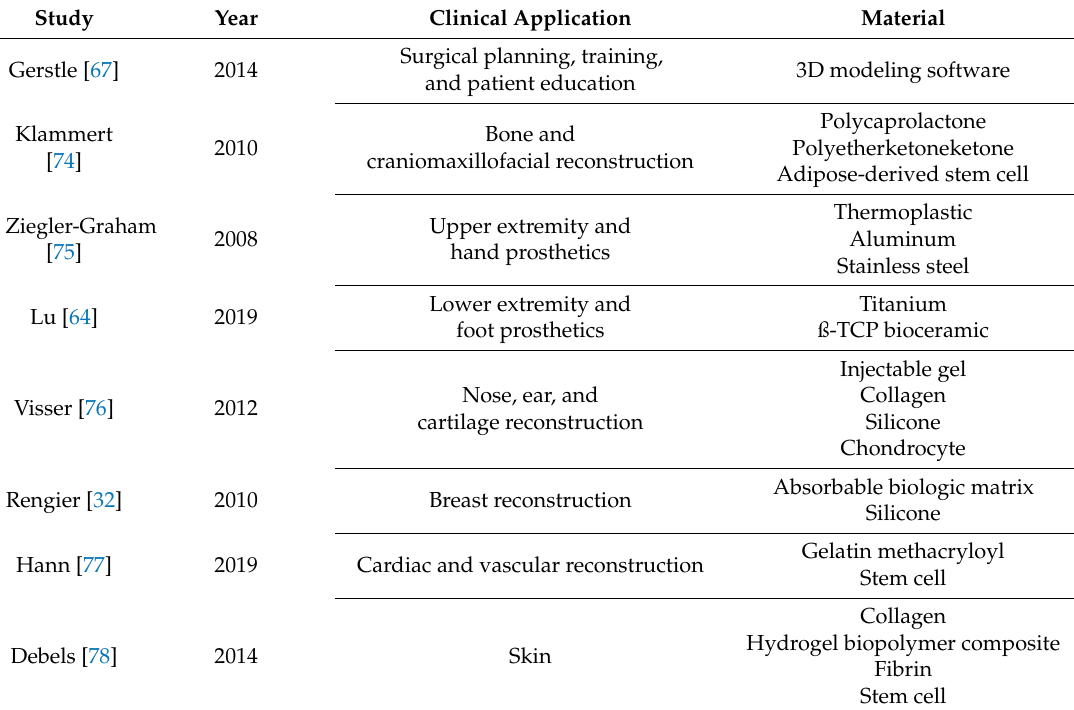
Table 1. Clinical applications of 3D printing in surgical